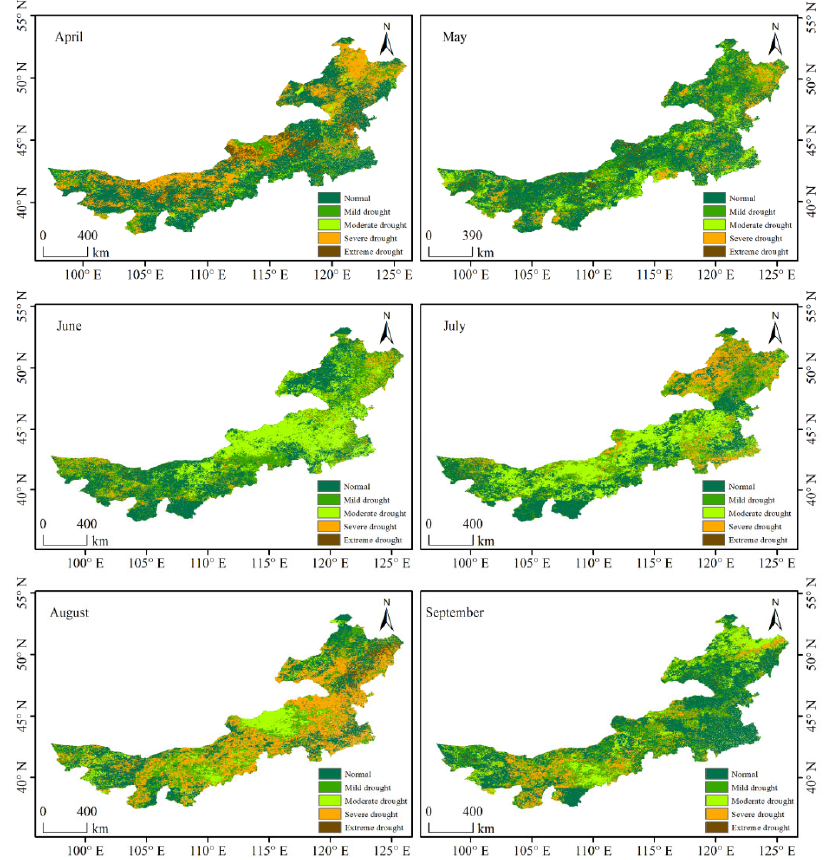
Figure 4. Monitoring results of the drought model during the growing season in 2012.